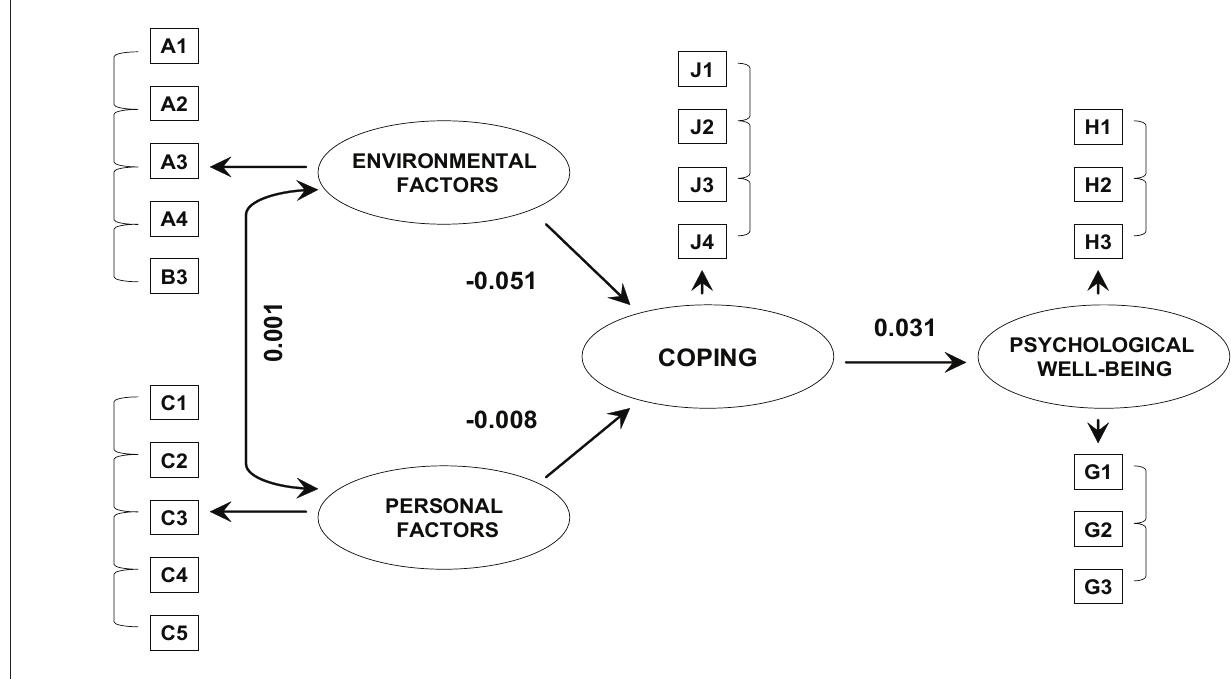
FIGURE 2 A measurement and structural model in terms of Moos’s (1994)